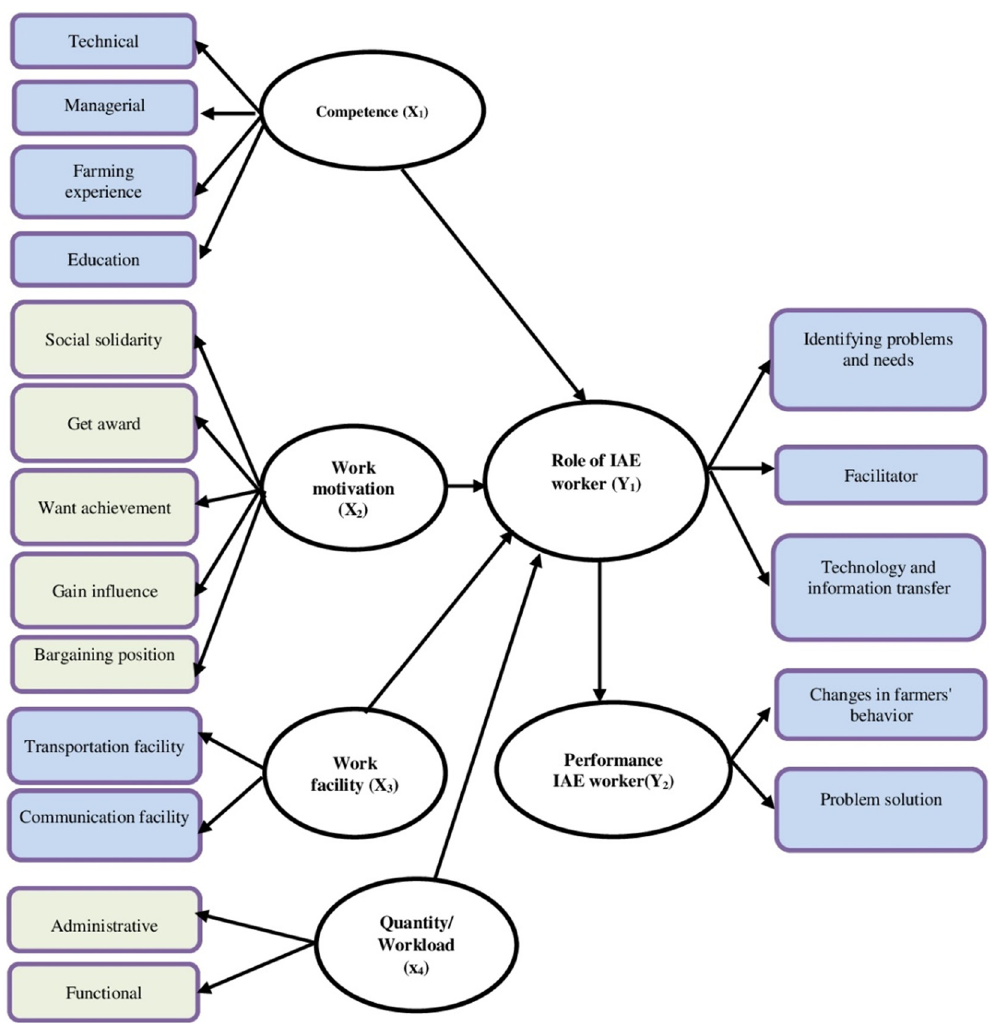
Figure 1: A hypothetical framework of research